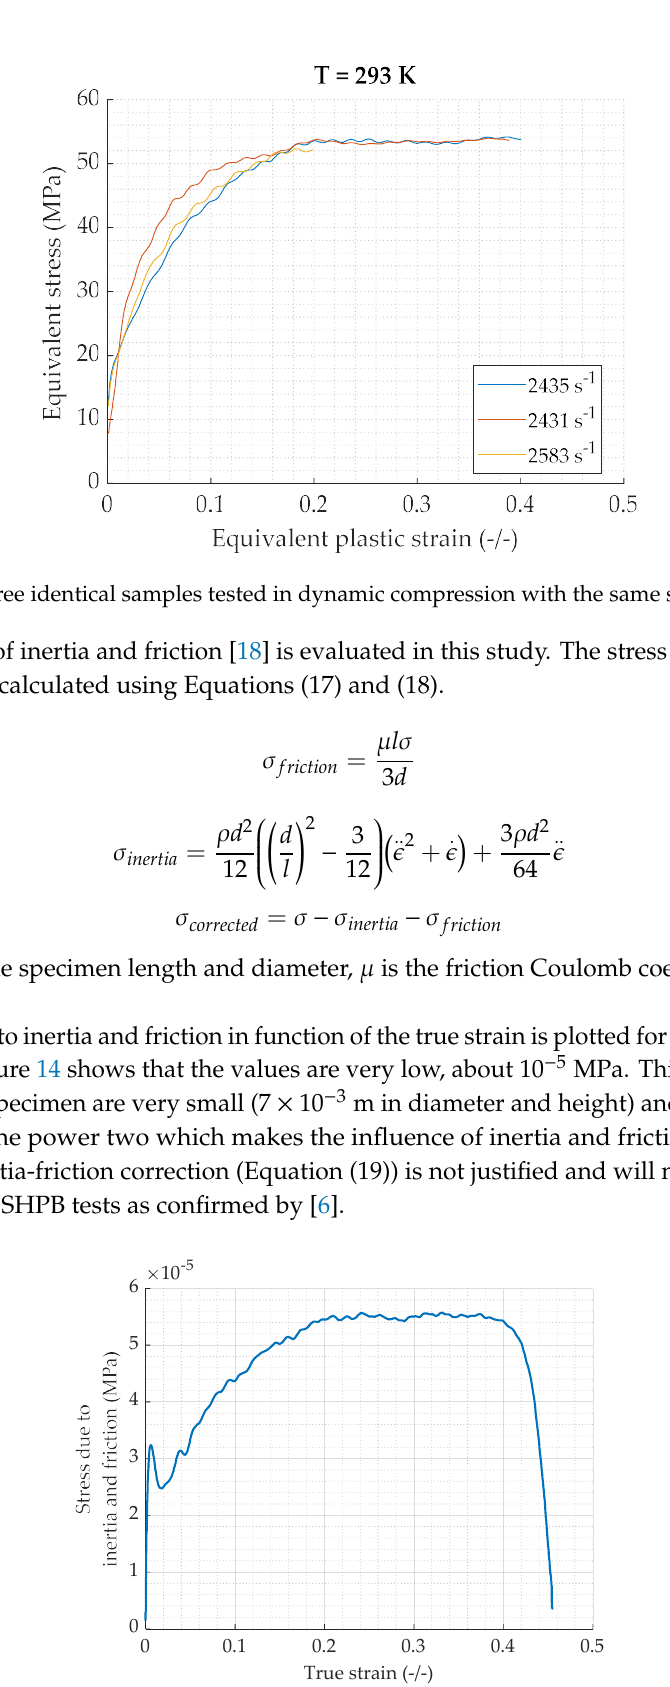
Figure 14. True stress induced by inertia and friction as defined in Equation (23).